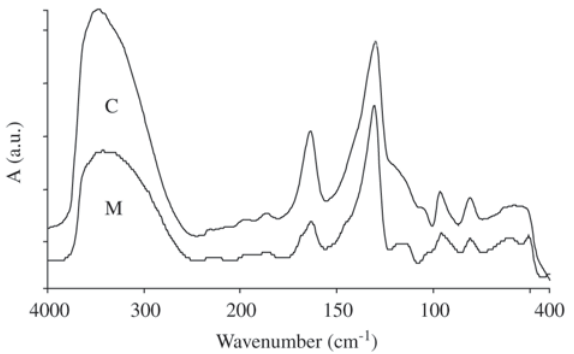
Figure 6. FTIR spectra of silica gels obtained via conventional (C) heating and via microwave (M) heating.